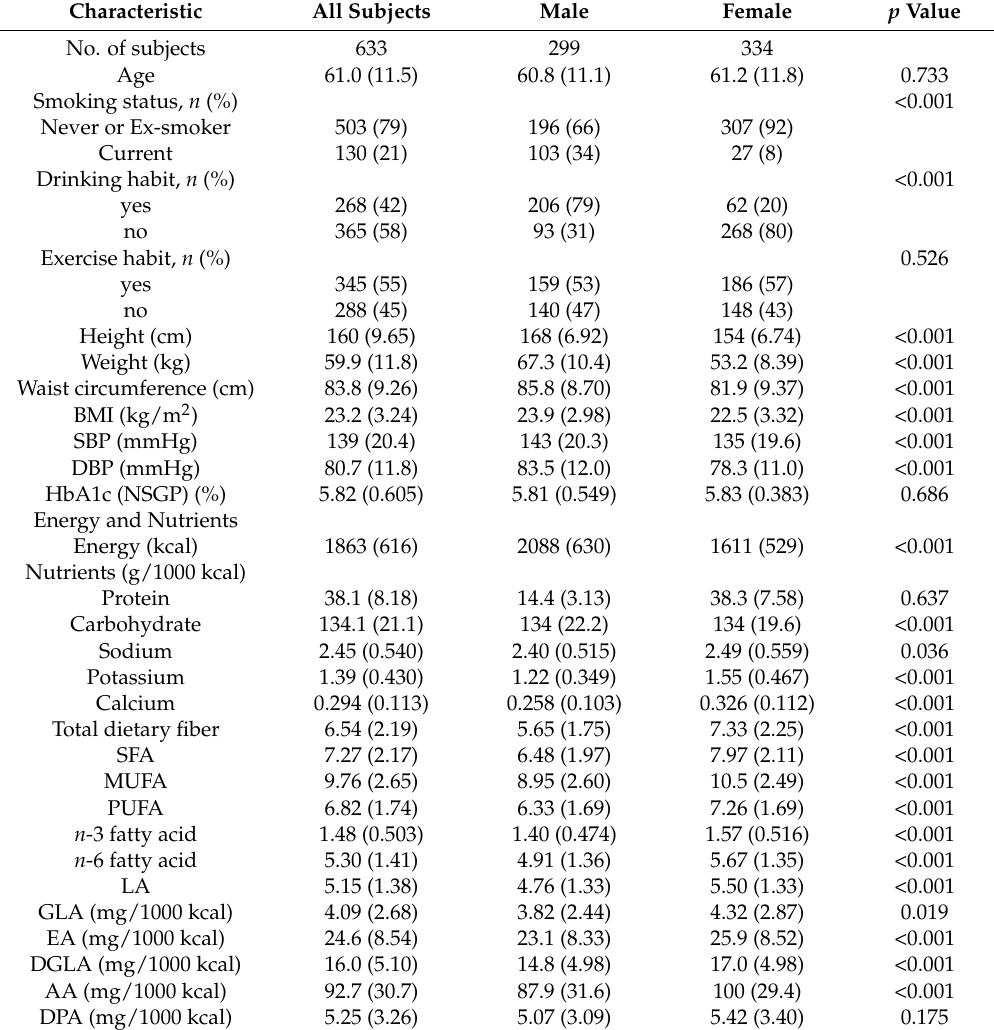
Table 1. Participant characteristics in different blood pressure